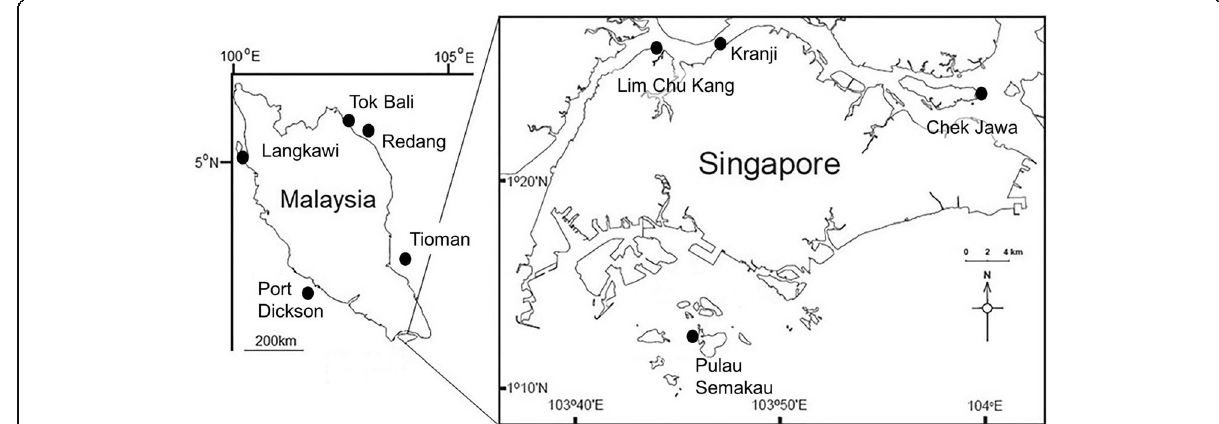
Fig. 1 Map of sampling locations throughout Singapore and Peninsular